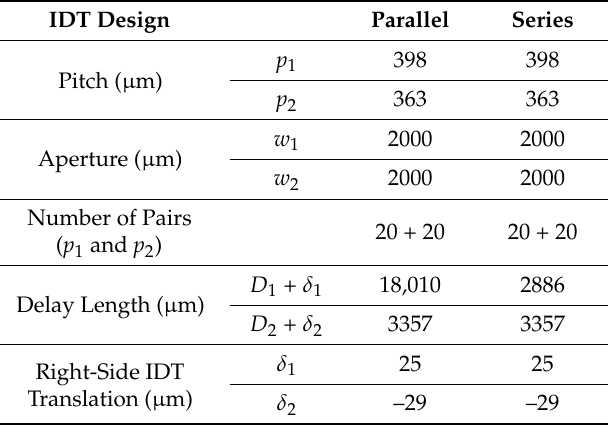
Figure 2. ( a ) Parallel and ( b ) series configurations of IDT designs for generating switchable dual-wavelength SSAW fields. In the parallel (series) IDT design, IDTs of two different pitches (denoted as p 1 and p 2 ) are connected in parallel (series). Table 1. IDT geometrical parameters.